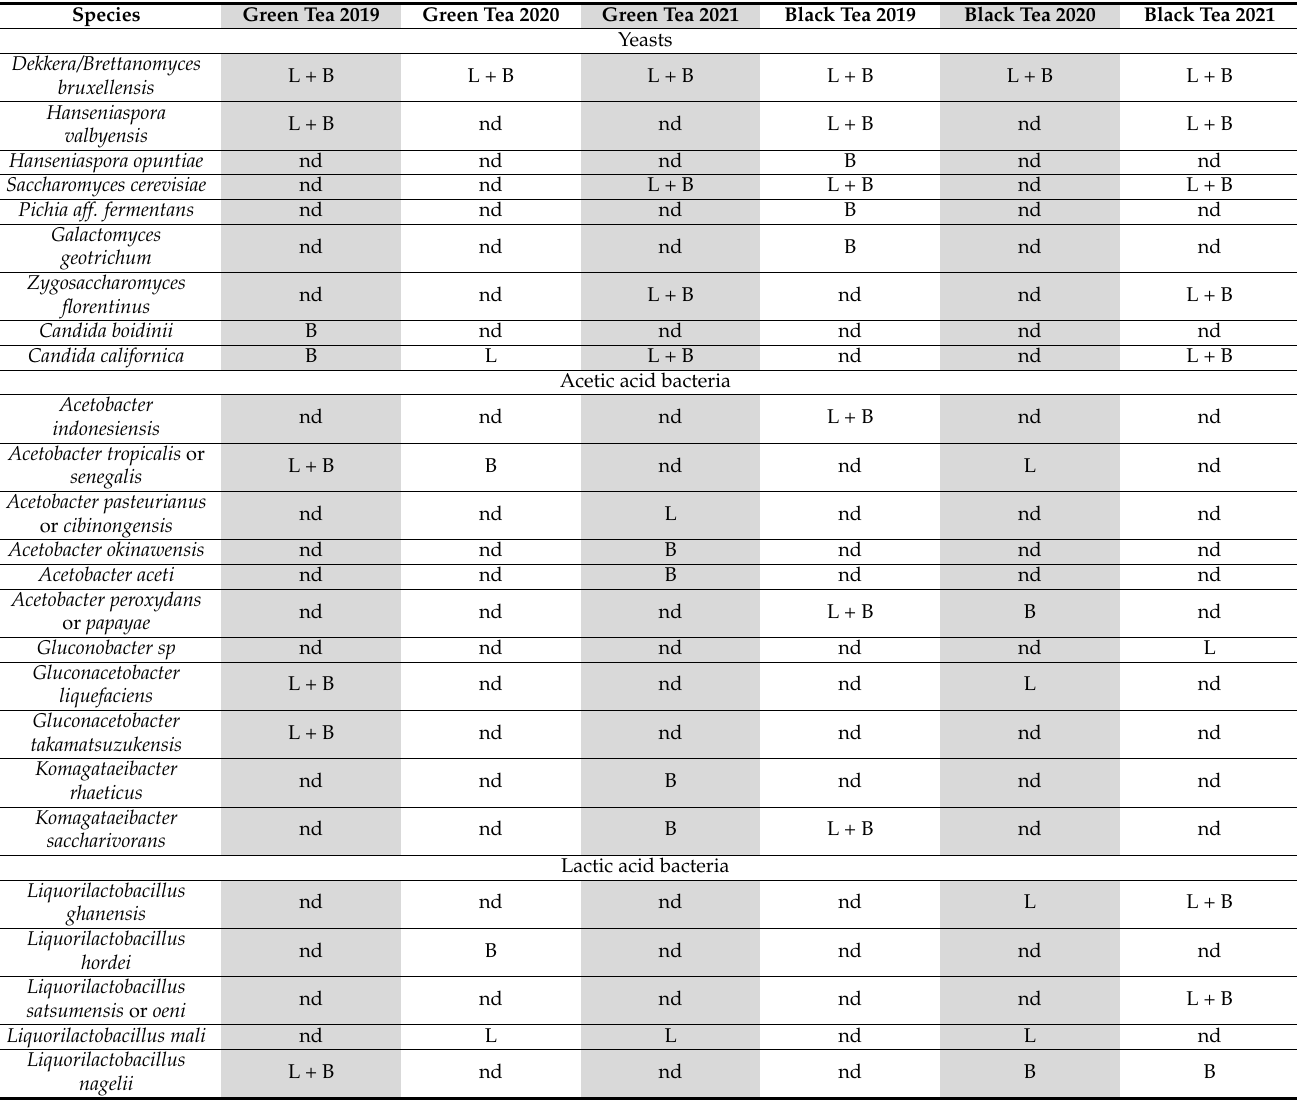
Table 3. Identification of yeasts and bacteria in black and green tea kombucha liquid and biofilm samples over 3